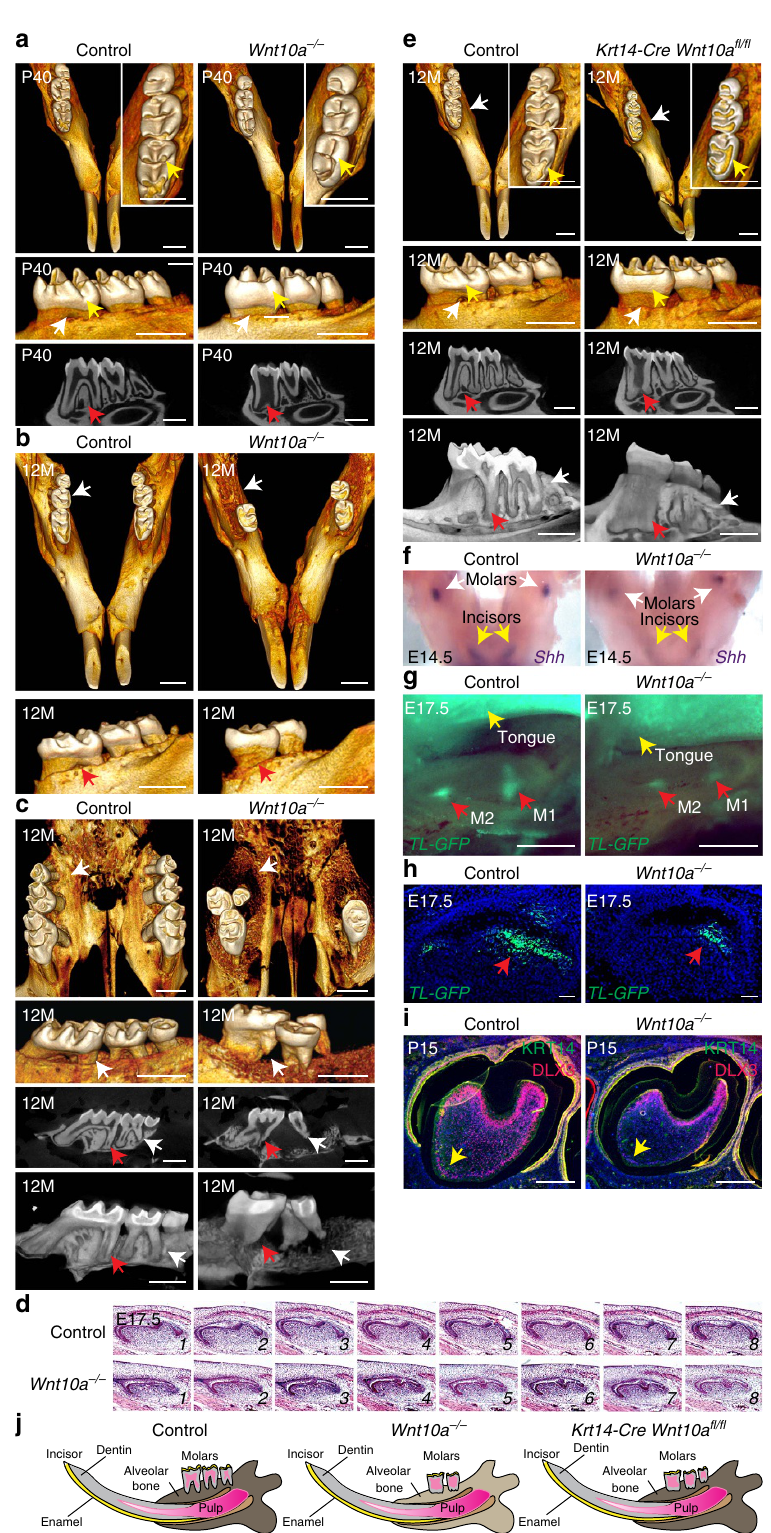
Figure 3 | Tooth defects in Wnt10a mutant mice. ( a – c ) Micro-CTanalysis of mandibles ( a , b ) and maxillae ( c ) from control and Wnt10a (cid:2) / (cid:2) mice at the stages indicated. ( d ) Serial H&E-stained sections reveal smaller molar M1 size and blunted cusp development in E17.5 Wnt10a (cid:2) / (cid:2) mutant. ( e ) Micro-CT analysis of Krt14-Cre Wnt10a fl/fl and control littermate mandibles at 12 months. ( f ) Whole-mount in situ hybridization of E14.5 control and Wnt10a (cid:2) / (cid:2) mandibles with Shh probe. ( g , h ) Analysis of whole mount ( g ) or frozen sections ( h ) of E17.5 Wnt10a (cid:2) / (cid:2) TL-GFP and control TL-GFP developing molars shows decreased GFP signal in mutant cusp precursors. ( i ) Immunofluorescence for KRT14 (green) and DLX3 (red) in P15 mandibular molar from control and Wnt10a (cid:2) / (cid:2) littermates. Dlx3 expression is reduced in the mutant. ( j ) Diagram summarizing Wnt10a mutant tooth phenotypes at 12 months of age. Scale bar, 50 m m ( h ), 250 m m ( i ) or 1mm (all other